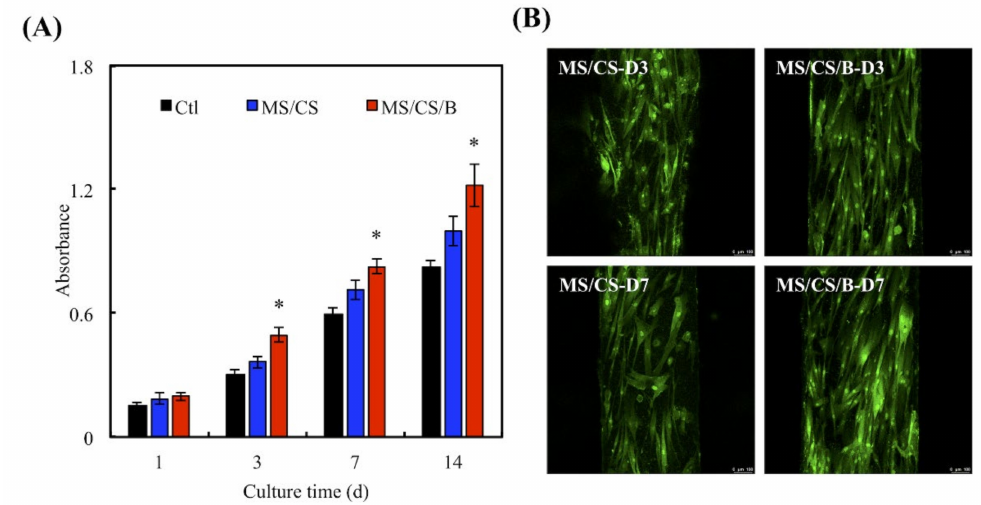
Figure 6. ( A ) The proliferation of the human dental pulp cells (hDPSCs) cultured on scaffolds for 1, 3, 7, and 14 days. * indicates a significant difference ( p < 0.05) when compared to MS/CS. ( B ) F-actin filament (green) staining of hDPSCs cultured on different scaffolds for 3 and 7 days. The scale bar of the photograph is 100 µ